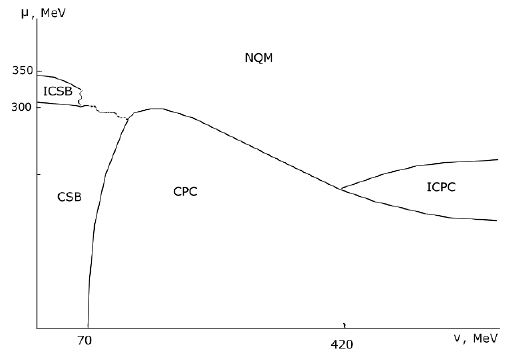
Figure 2 . ( (cid:23) 5 ; (cid:22) )-phase diagram at (cid:23) = 0 and (cid:22) 5 = 0. This plot is duality conjugated one to a phase diagram of (cid:12)gure 1. All the notations are the same as in (cid:12)gure 1. The parts that cannot be drawn with certainty from the duality only are shown with curvy lines. In principle, there could be CPC phase below ICPC one but it is known from other studies that there is no homogeneous CPC phase in this